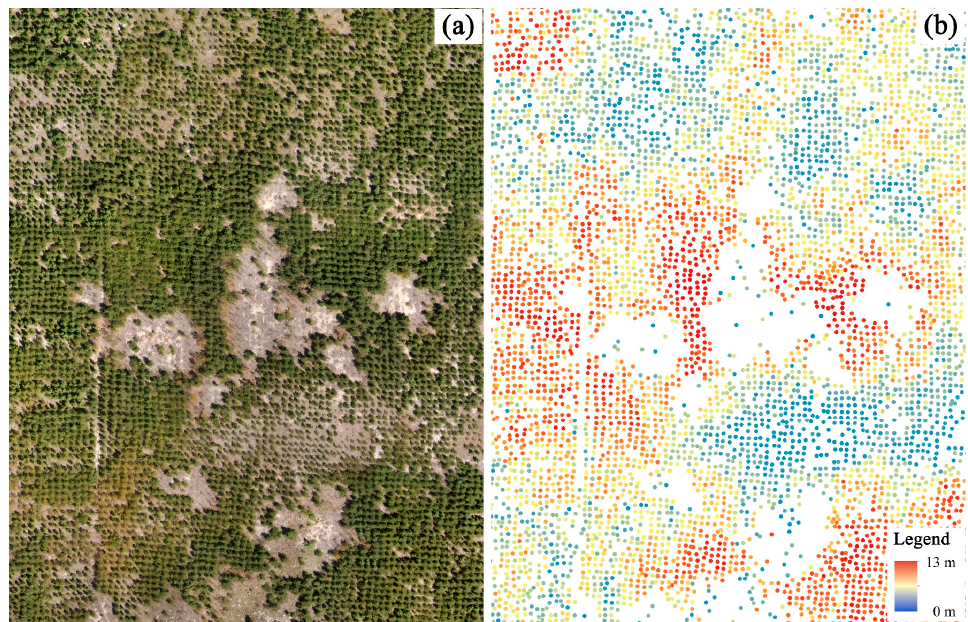
Figure 5. The results of Casuarina equisetifolia identification and tree-height detection at the flight height of 80 m. ( a ) UAV image and ( b ) results of ITD and tree-height detection.